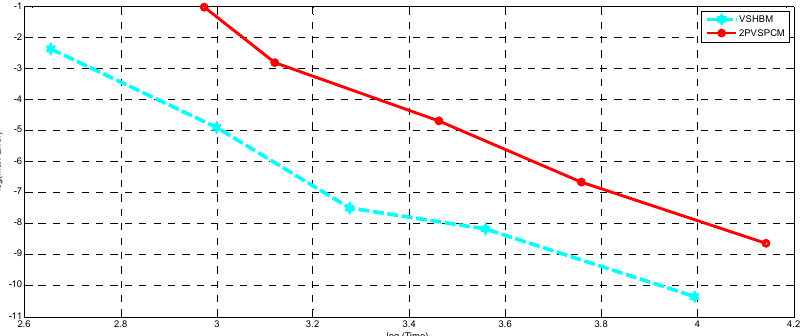
Figure 4. Efficiency curves for Kepler problem in terms of time versus maximum error.